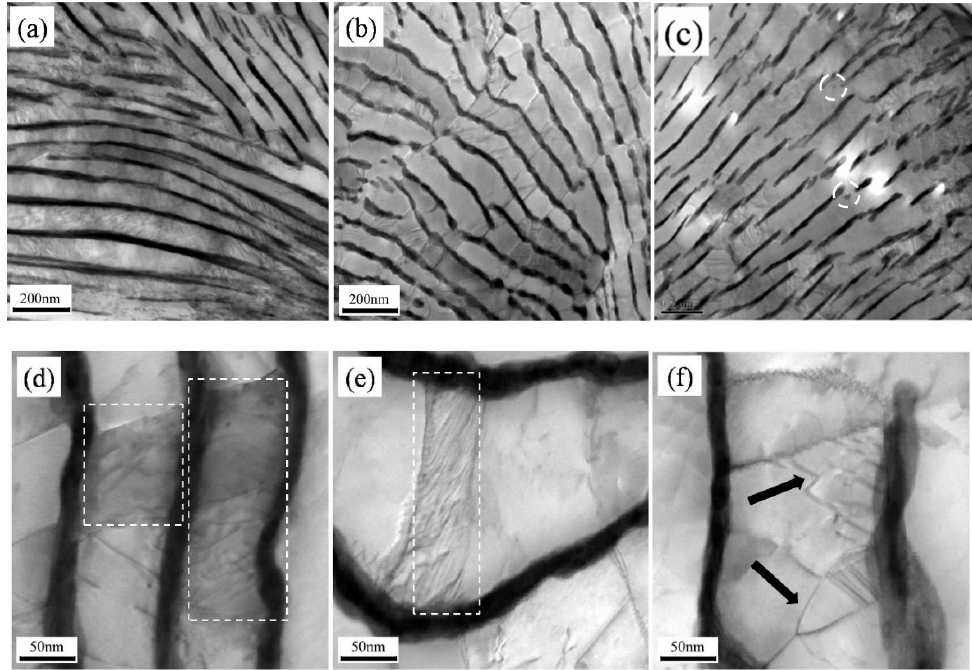
Figure 4. Typical TEM micrographs acquired at the cross-sections of wires: ( a , d ) cold-drawn wires, surface; ( b , e ) cold-drawn wires annealed at 450 ◦ C for 5 min; ( c , f ) cold-drawn wires annealed at 450 ◦ C for 15 min.